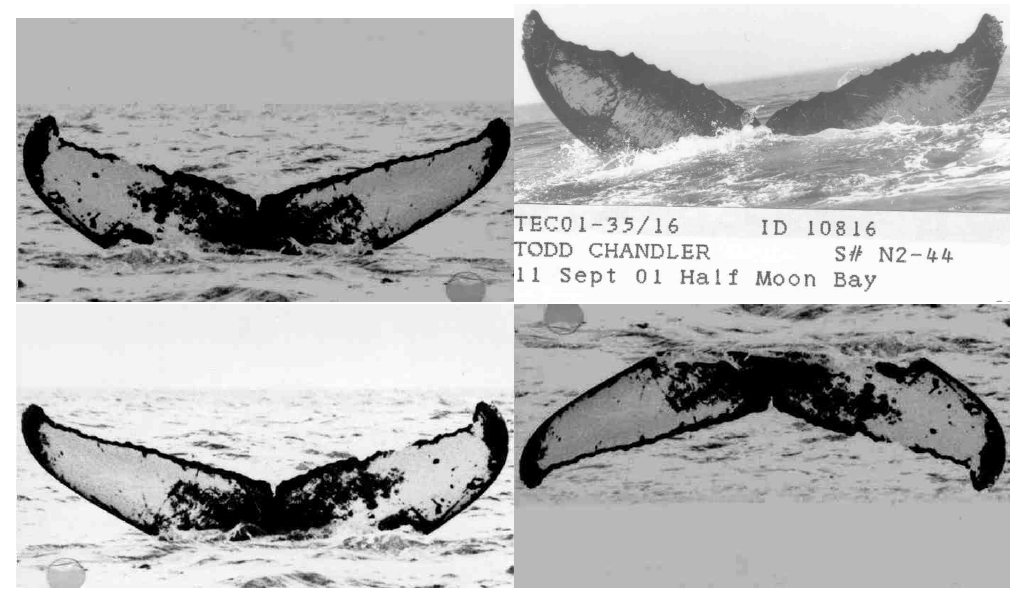
Figure 10. Augment over specimen